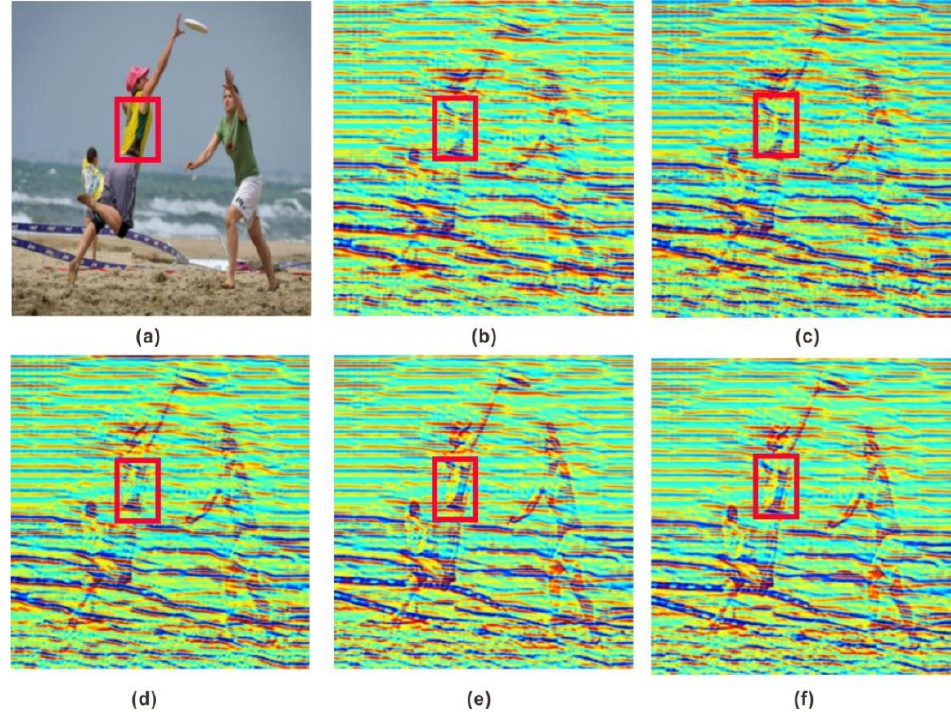
Figure 9. First training results of revision network. ( a ) Content. ( b ) Content weight = 1.0; style weight = 3.0; and the woman’s clothing contour is fuzzy. ( c ) Content weight = 1.0; style weight = 2.0; seismic profile is obviously stylized; and the woman’s clothing details are not prominent. ( d ) Content weight = 1.0; style weight = 1.0; and the contour is clear, but the color is not obvious. ( e ) Content weight = 2.0; style weight = 1.0; the woman’s clothing is similar in color to ( a ) and more prominent. ( f ) Content weight = 3.0; style weight = 1.0; and the effect is equivalent to ( e ).